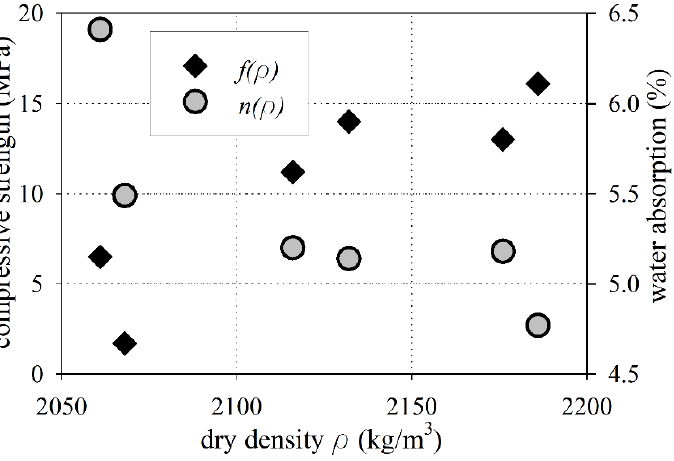
Figure 8. Compressive strength after 50 freezer cycles and water absorption vs. dry density.